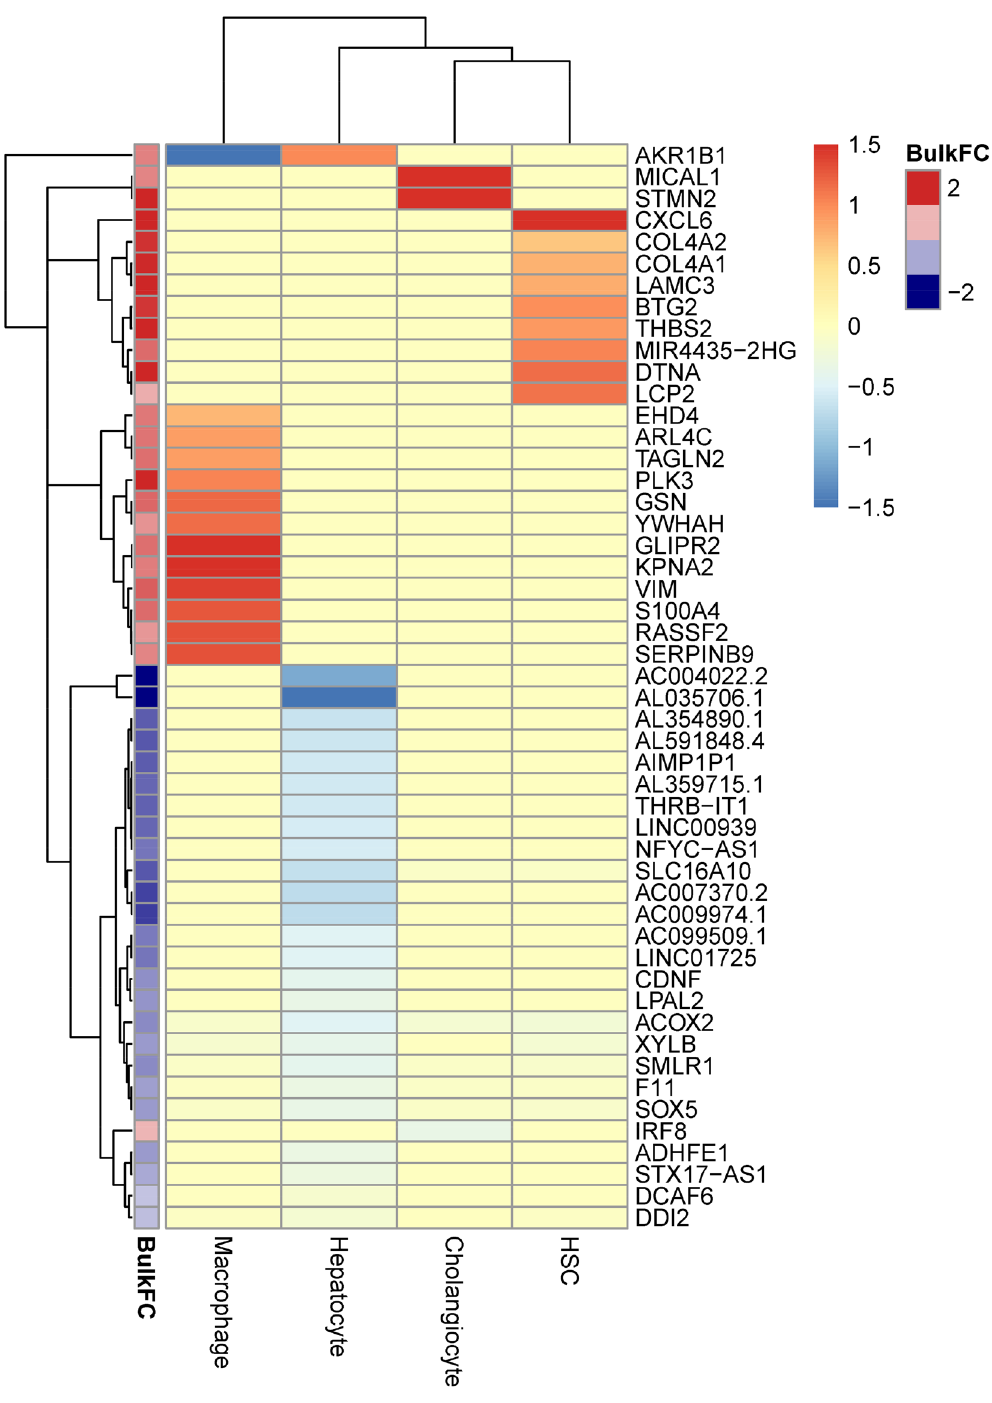
Figure 6. Cell type-specific differential expression of the 98-gene signature. The 98-gene signature includes 62 genes that are included in the cell type-specific marker genes with information on cell type-specific differential expression. Color code shows the cell type-specific log2 fold change in NASH F3/F4 versus Non-NASH as inferred from the deconvolution analysis. The annotation column on the right indicates the log2 fold change in the bulk RNASeq